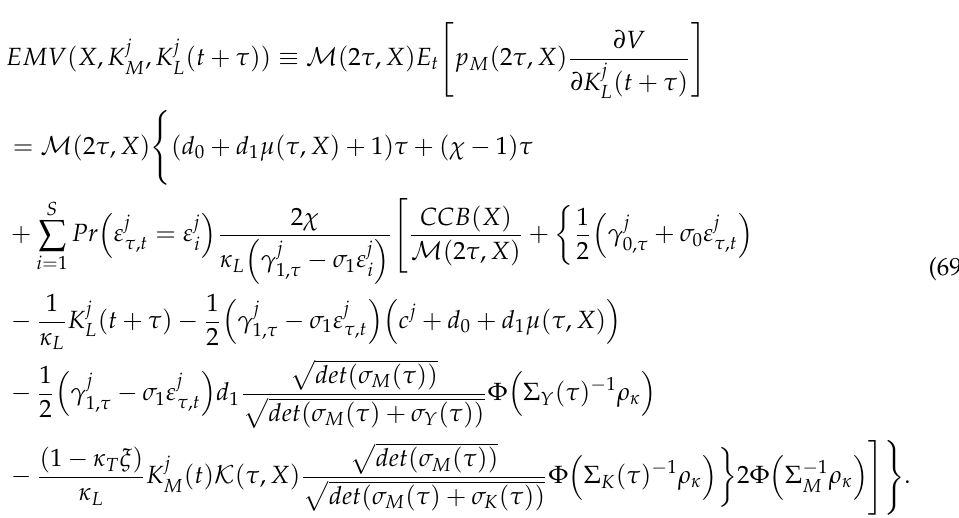
(69) and optimal K j L